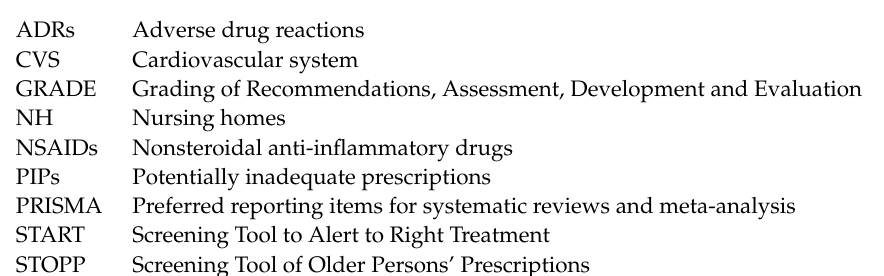
Table A1. Detailed PubMed search strategy